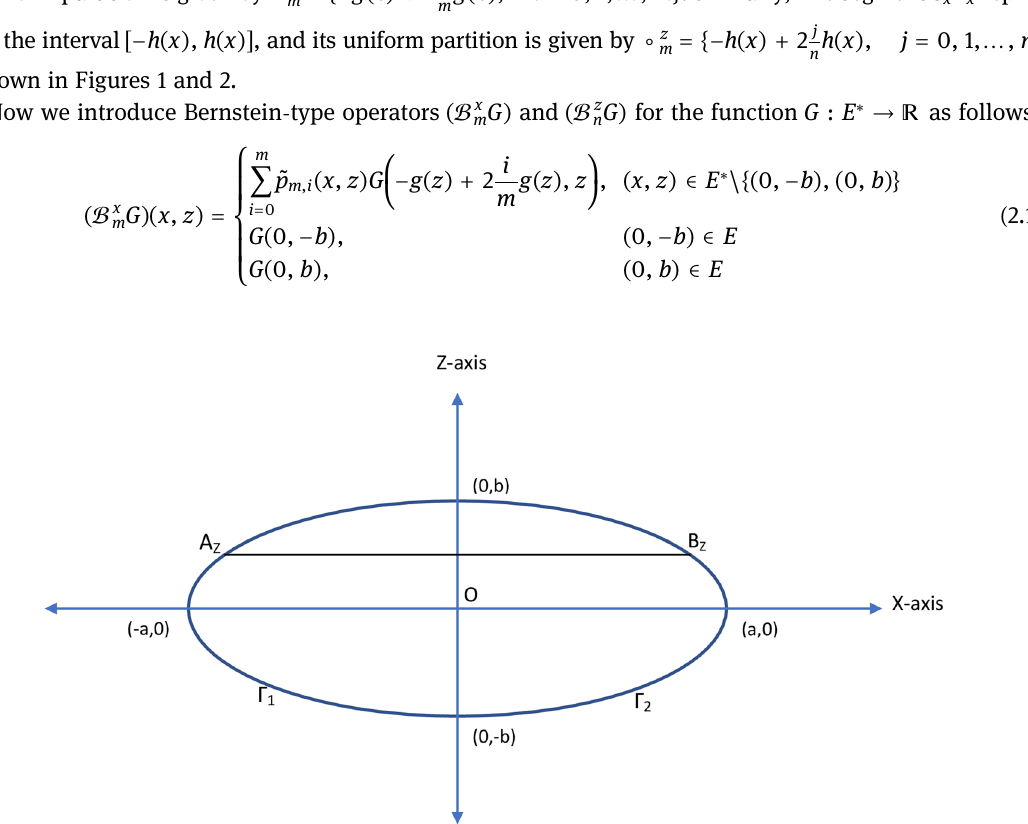
Figure 1: Elliptic